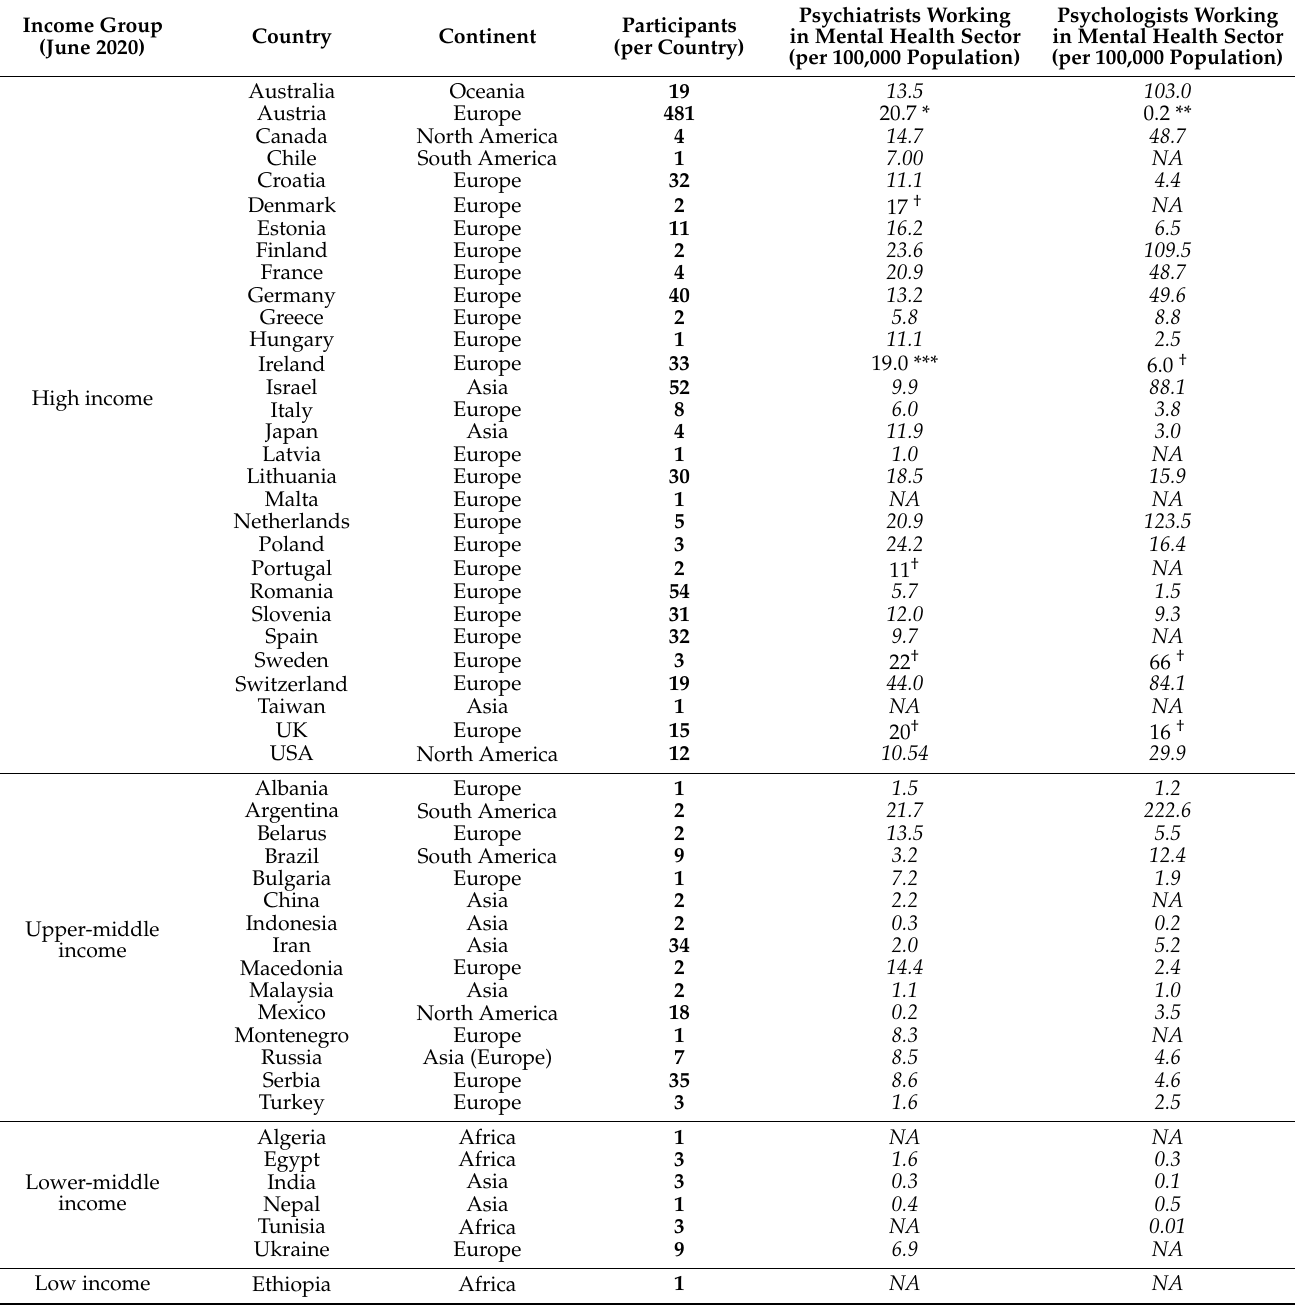
Table 1. Income levels, country, and number of psychiatrists/psychologists working in the mental health